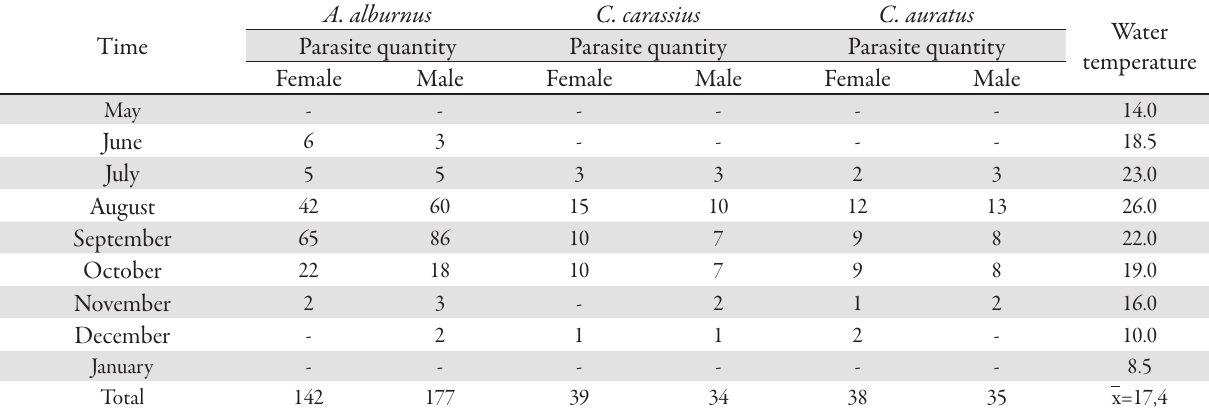
Tab. 1. The quantity of parasite seen according to the gender of the fish species and water temperature Time